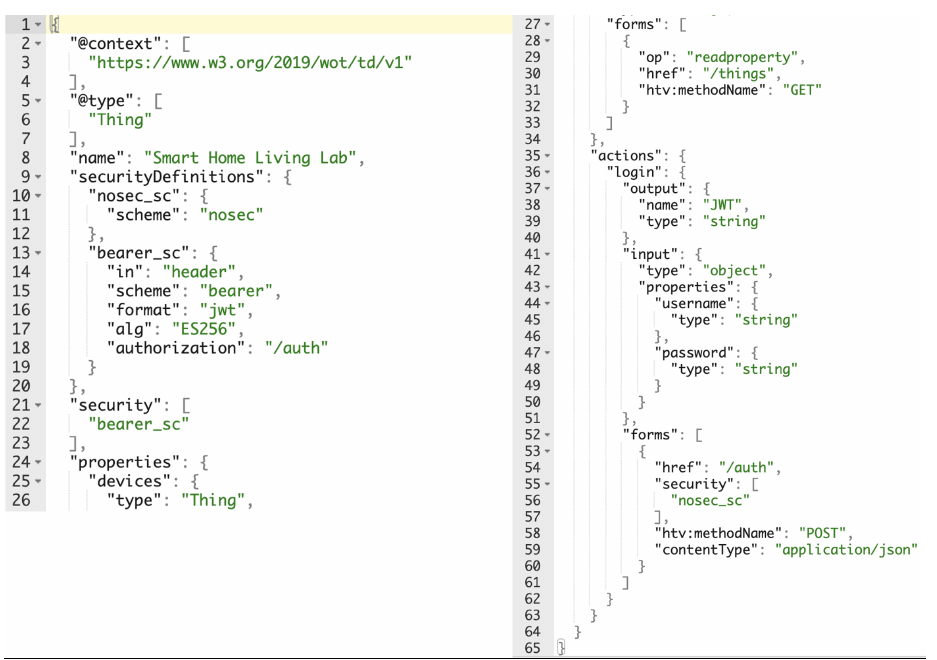
Figure 6. Living Lab Gateway Thing